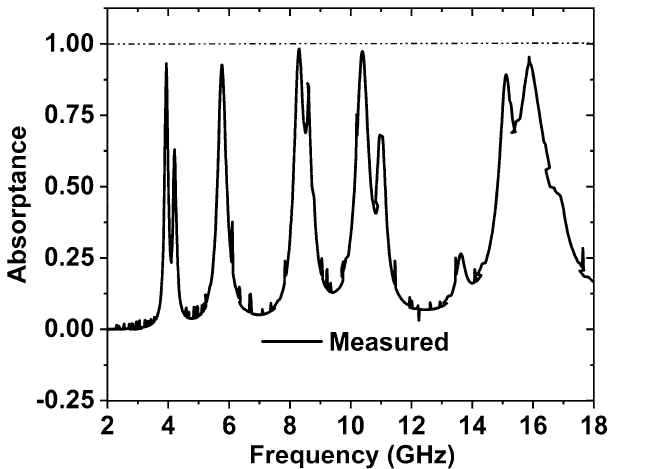
Figure 25. Measured array graph of the suggested